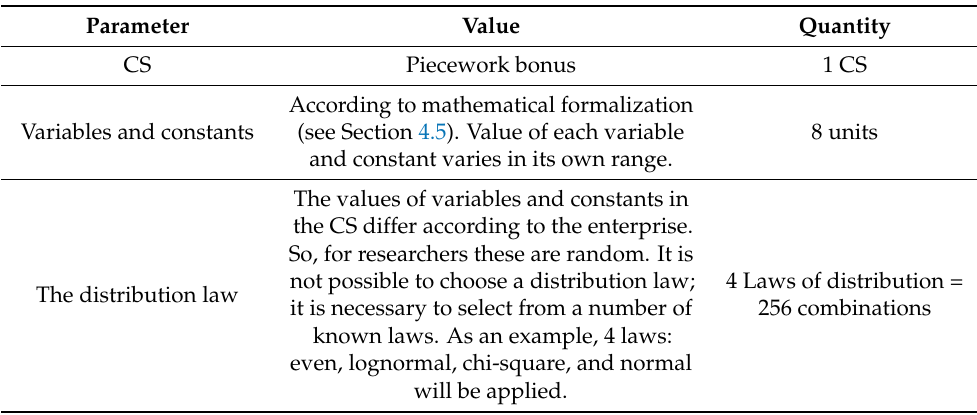
Table 1. Piecework-bonus CS variability.